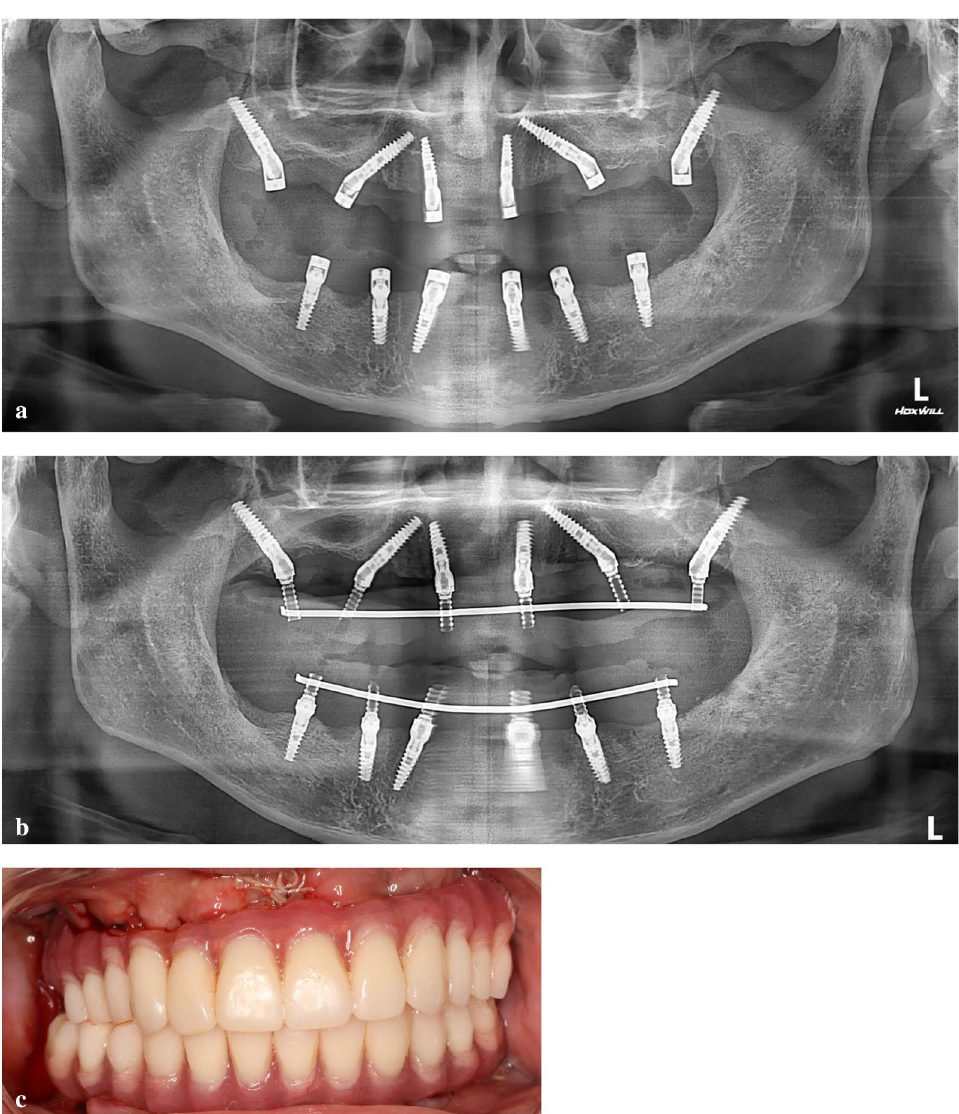
Fig. 3 A Panoramic radiograph was taken immediately after implant placement. B Panoramic radiograph was taken after transfer copings splinted. C Occlusal